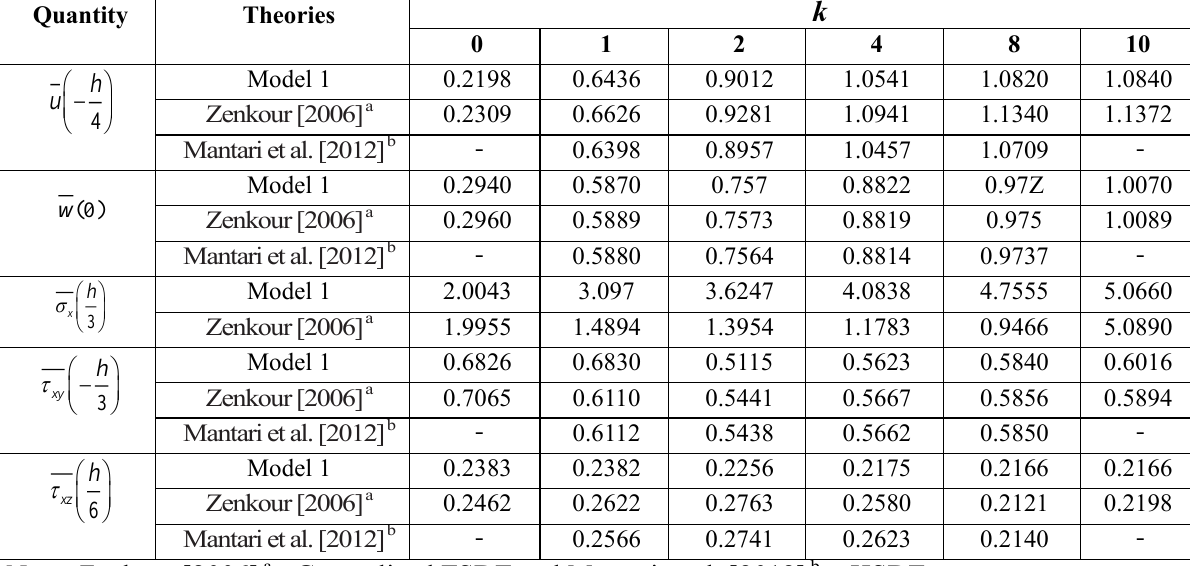
Normalized in-plane and transverse displacements  , u w , in-plane normal and shear stresses and transverse shear stresses      ,  xxxy sinusoidal loading for side to thickness ratio 10 for Mechanical Loading for material set